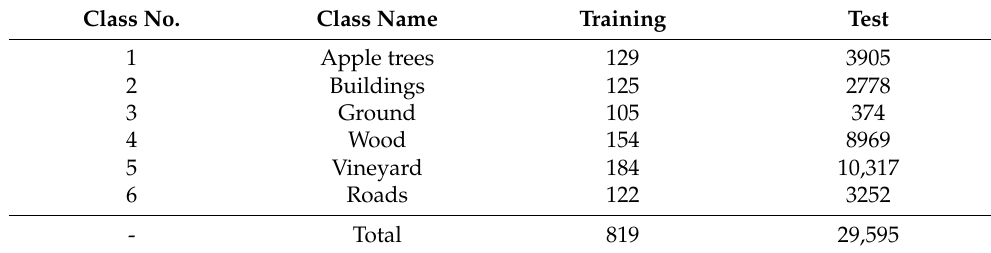
Table 2. Sample distribution of Trento dataset.